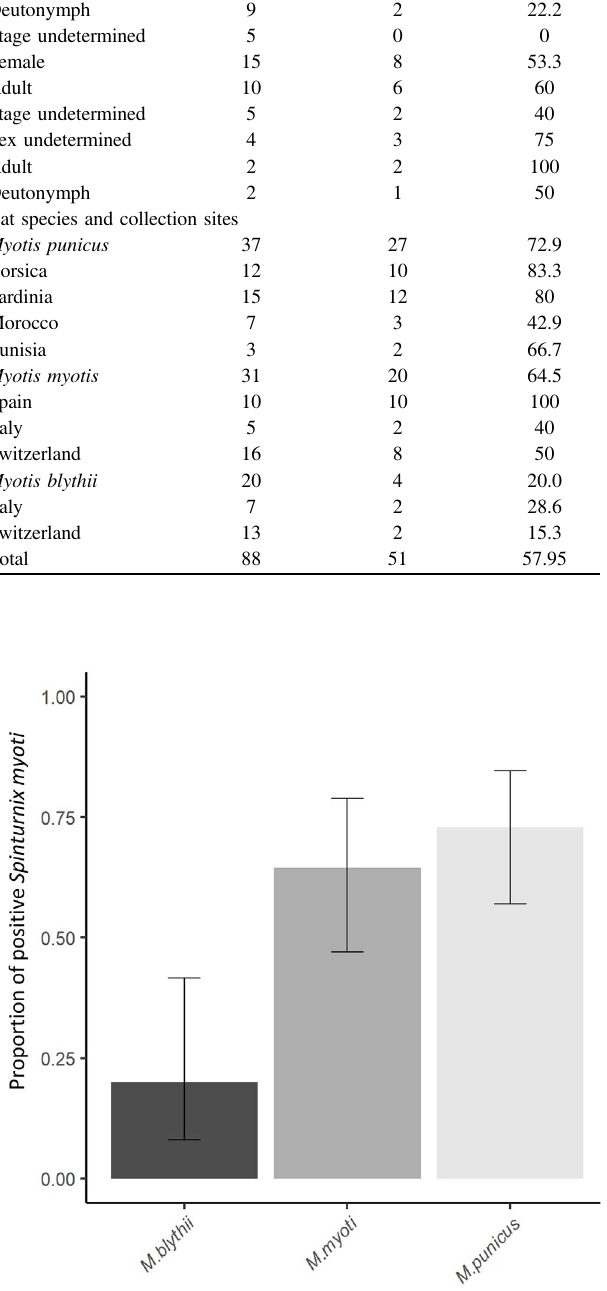
Figure 1. Prevalence of Chlamydiae in Spinturnix myoti as a function of their host species. Bars represent the 95% con fi dence